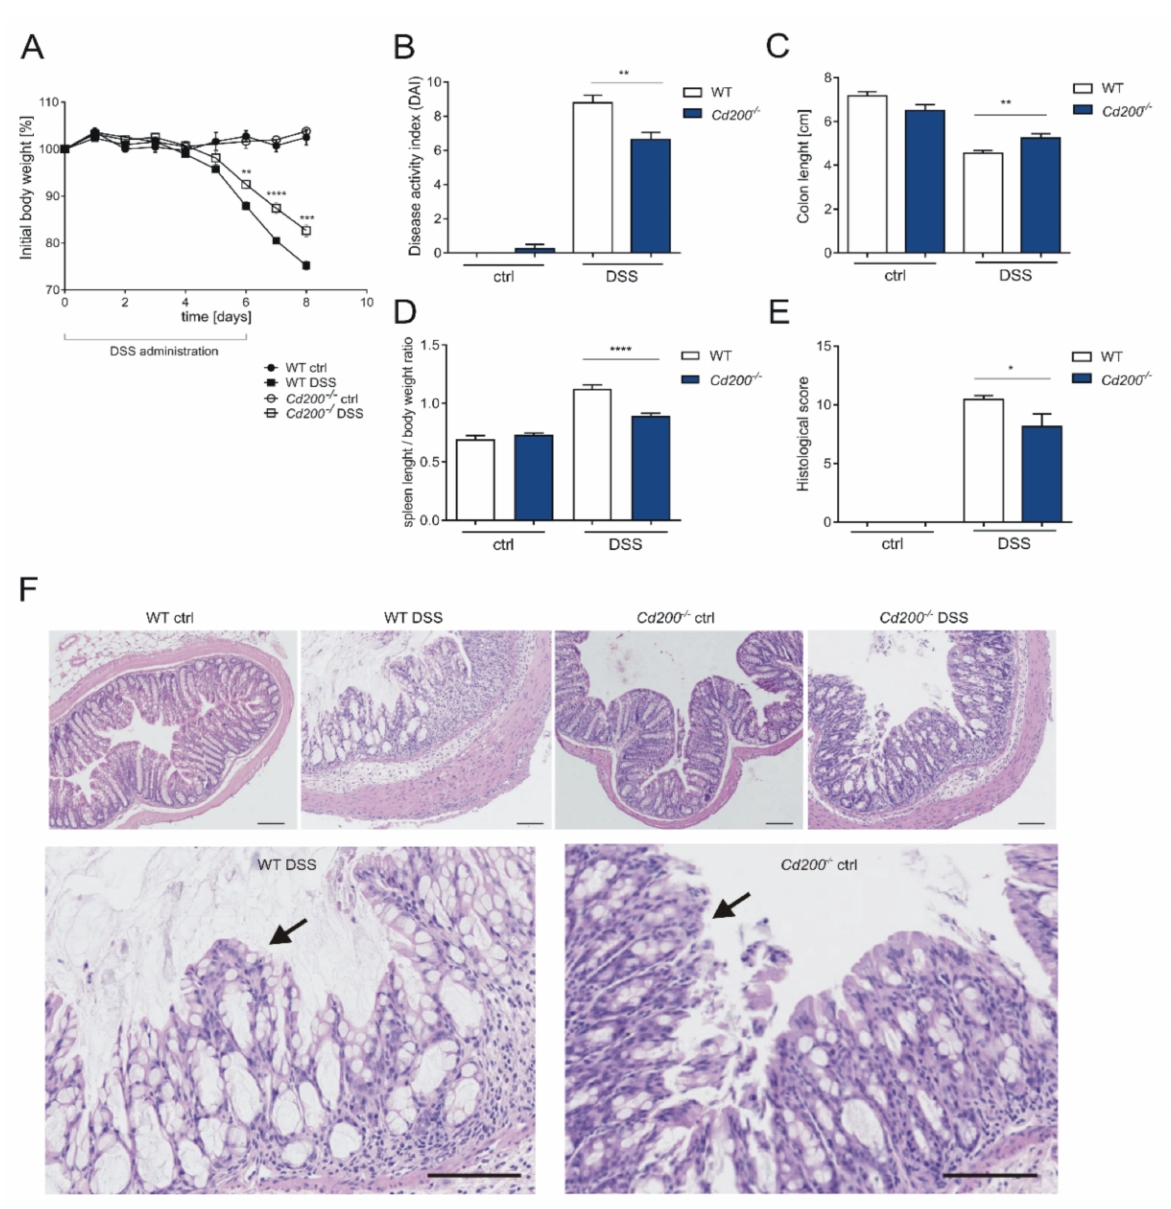
Figure 1. Characteristic of DSS-mediated intestinal inflammation in WT and Cd200 − / − conventionally reared mice. ( A ) Body weight, expressed as the percentage of the initial body weight, n = 4–16; ( B ) Disease activity index (DAI) assessed on day 8, based on the changes in the following parameters: body weight loss, colon length, stool consistency, stool blood,